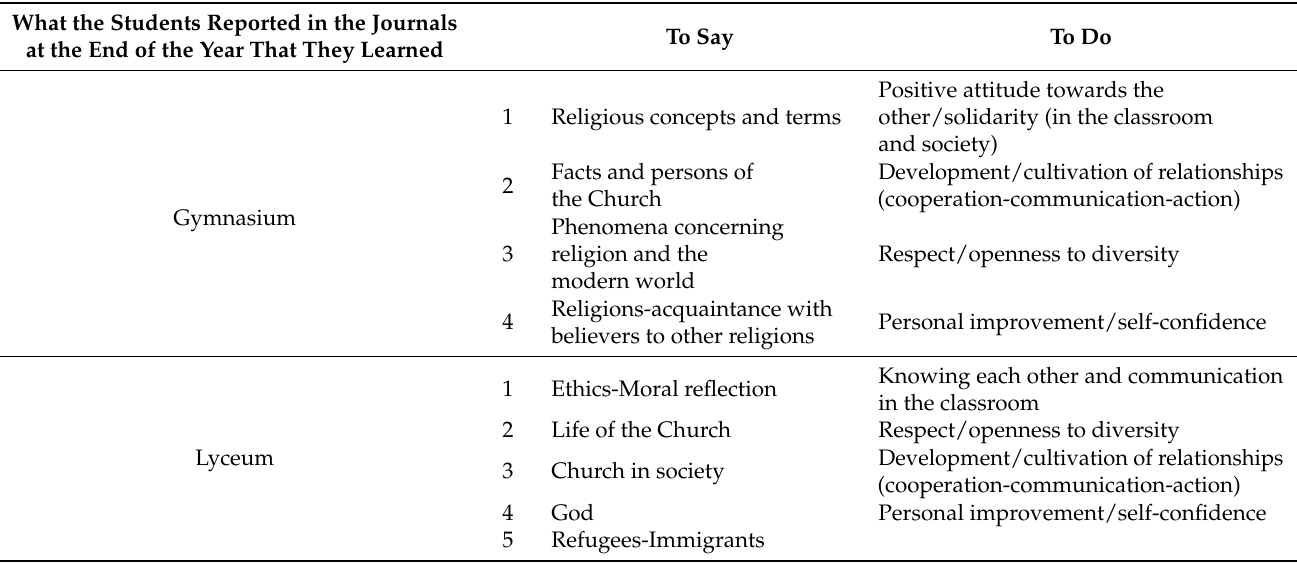
Table 7. What students stated in their journals at the end of the school year that they have learned to say and do.